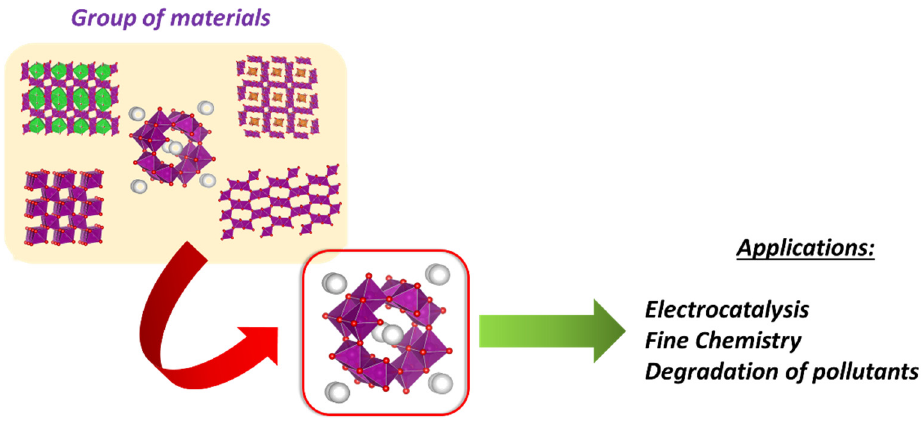
Figure 3. Most representative applications of nanostructured cryptomelane OMS–2.